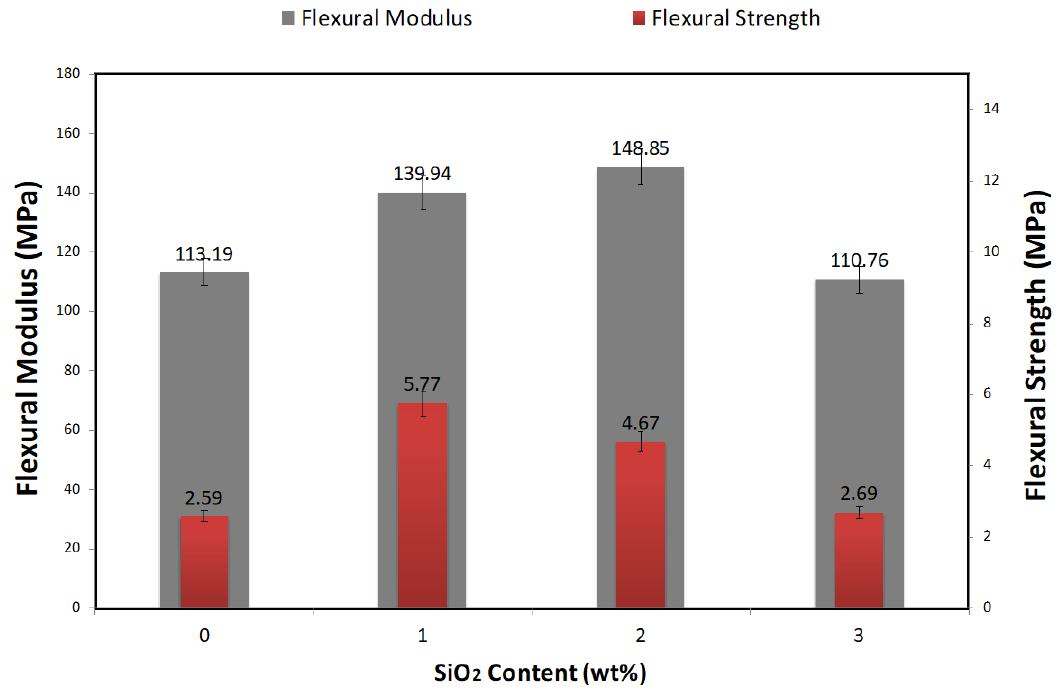
Figure 3. Variation of flexural modulus and flexural strength of all composites as a function of nanosilica contents.